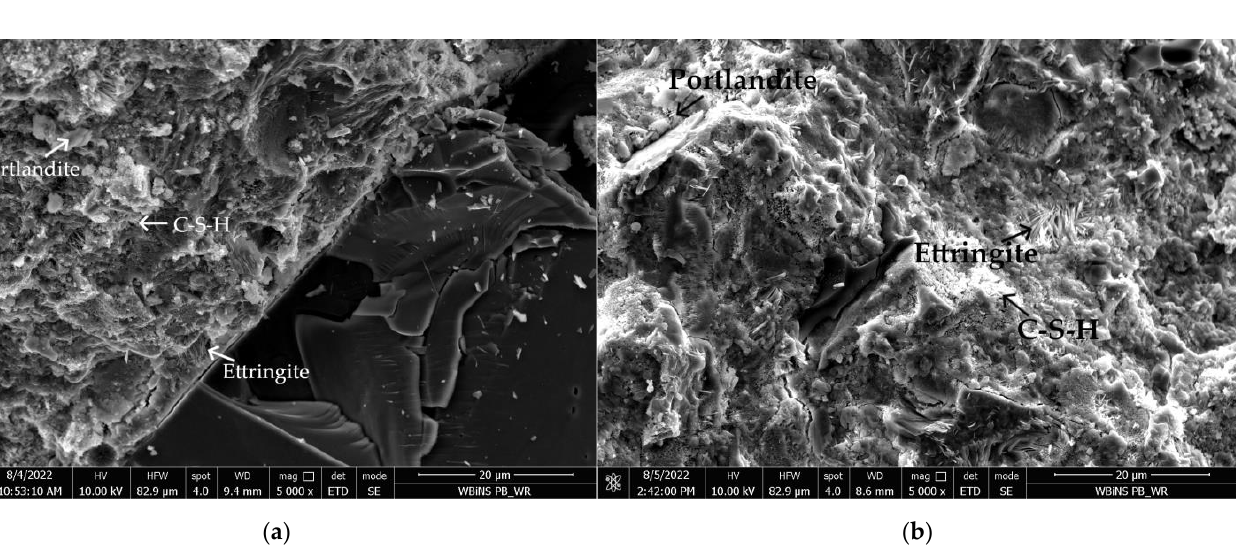
Figure 12. SEM photographs of cement mortar with a 25% addition of ( a ) fly ash sieved with 63 µm sieve (FA(B)63) and ( b ) untreated fly ash (FA(B)N). Noticeably, the microstructure of ettringite crystals was different between specimens with FA(B)63 and FA(B)N fly ash. Specimens with FA(B)N fly ash were characteristic of a very light structure of ettringite with very long-needle-shaped minerals (Figure 13a). In specimens with FA(B)63 fly ash, the microstructure of ettringite was different, with dense areas of short minerals (Figure 13b and Figure 14).